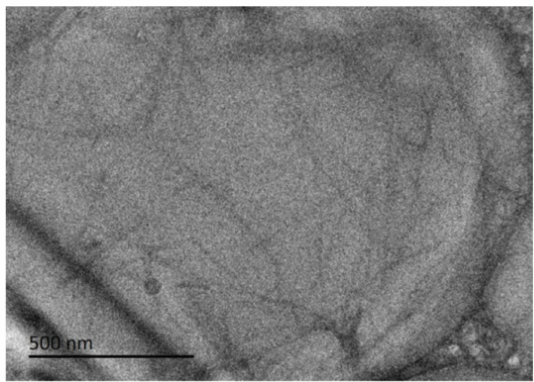
Figure 4. Cryo-TEM images of supramolecular hydrogel at 0.5 M.